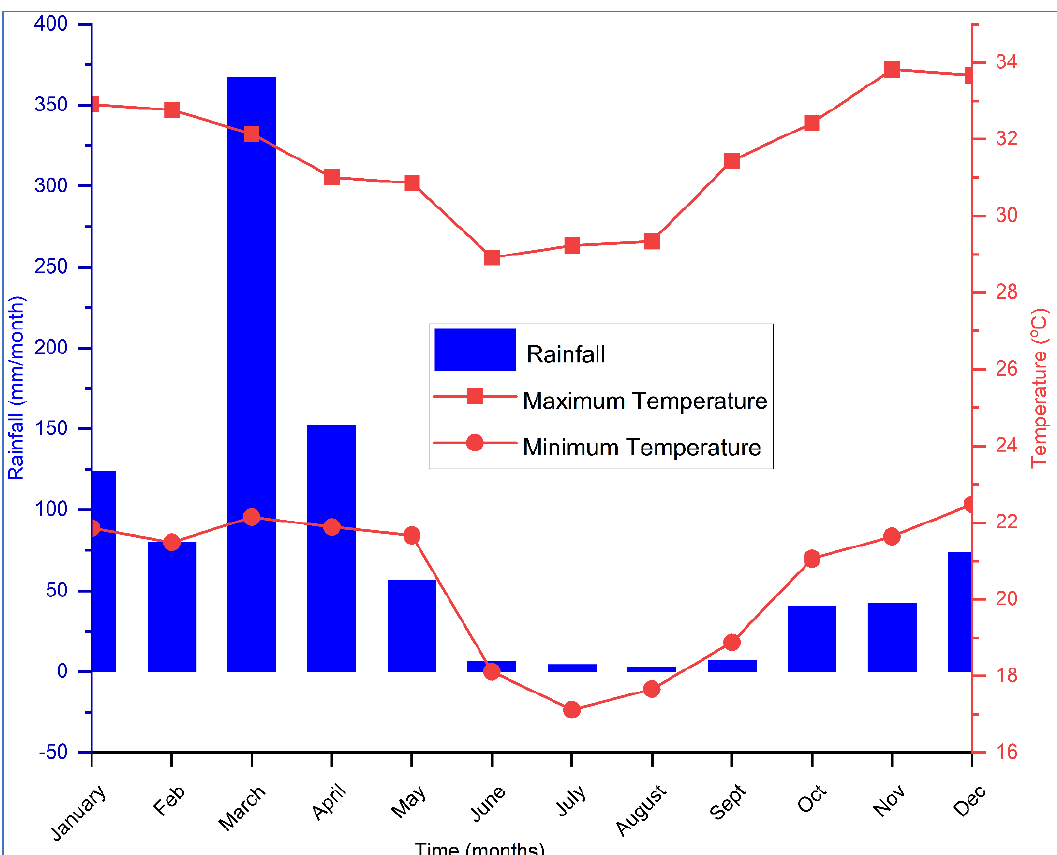
Figure 2. Monthly average rainfall and maximum and minimum temperature from 2007 to 2022 (Source: Tanzania Meteorological Agency-Morogoro).